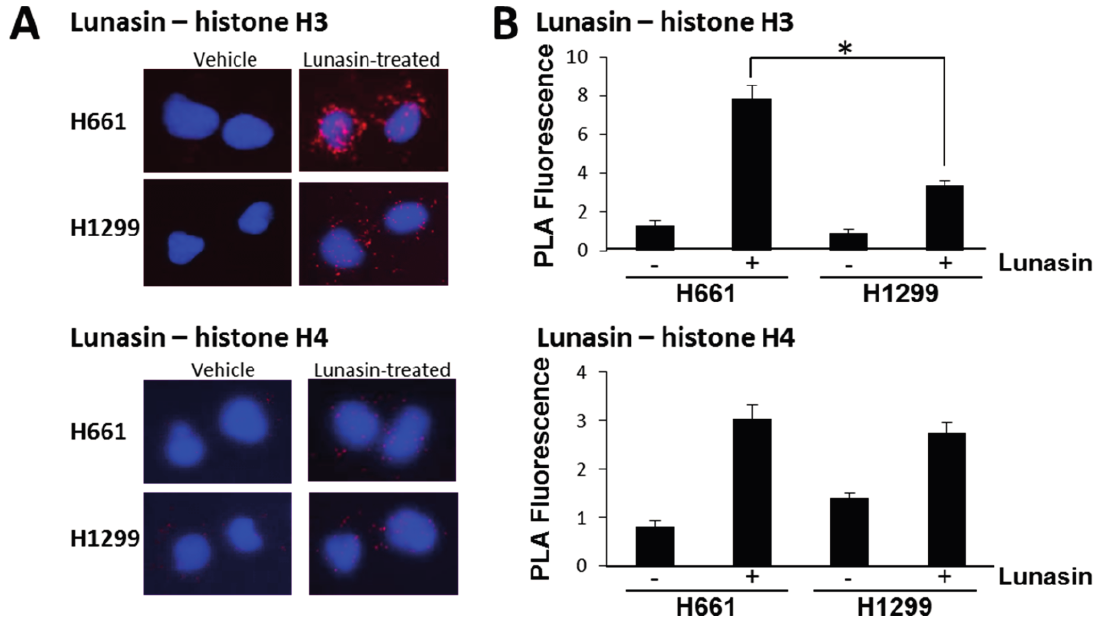
Figure 2. ( A ) Interaction of lunasin with core histones H3 and H4 in NSCLC cells. Cells were treated with 100 µM lunasin for 24 h before performing proximity ligation assays (PLA) assays using antibodies specific for lunasin, H3 and H4; ( B ) Quantitation of PLA fluorescence in NSCLC cells. Fluorescence is expressed as relative fluorescence per cell. Data shown are the mean ± SD obtained in three independent experiments where 40 cells per treatment were imaged in each experiment; asterisks indicate a statistically significant difference ( p < 0.05) between